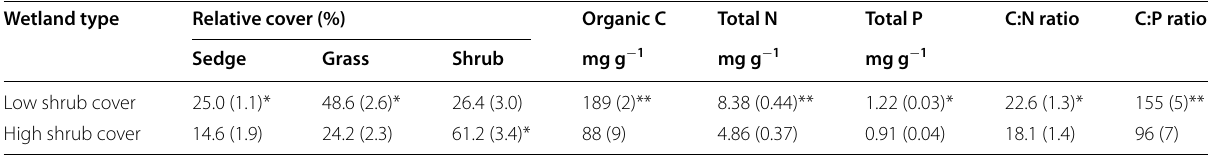
Table 1 Effect of shrub encroachment on vegetation composition and soil organic C, total N, and total P concentrations in freshwater wetlands of Northeast China